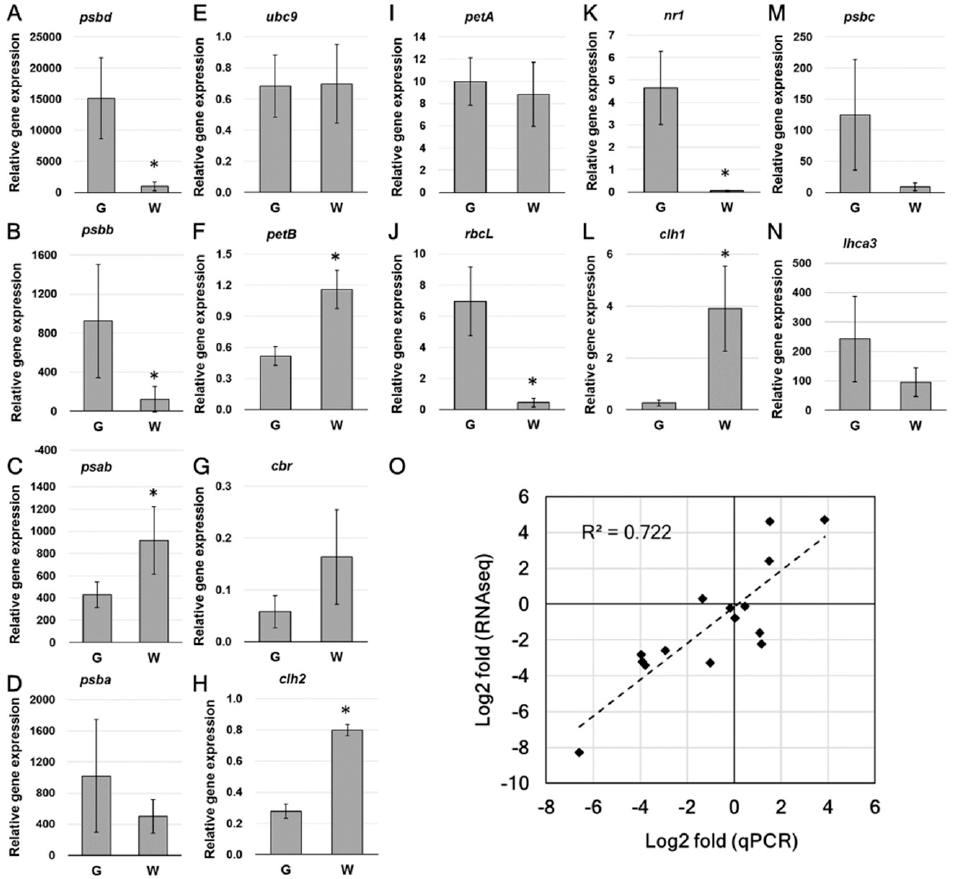
Figure 7. Real-time qPCR and the relationship of qPCR and RNAseq fold change. ( A – N ), qPCR analysis of the relative expression of selected DEGs. (O), Relationship of qPCR and RNAseq fold change. Folds are presented as Log2 value. Data are presented as the mean ± SD ( n = 5–6). * Significant difference between green and white sectors ( t -test, p < 0.05).